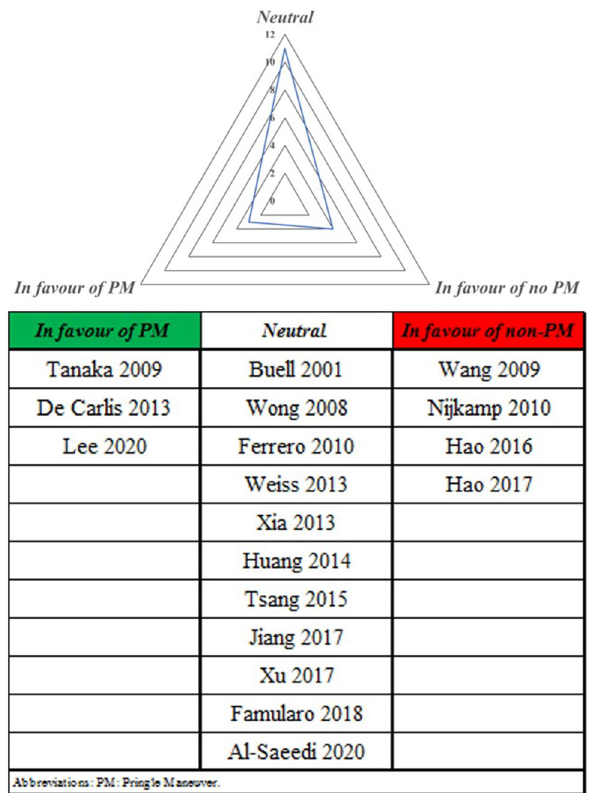
Figure 2. Distribution of studies according to oncological outcomes of Pringle